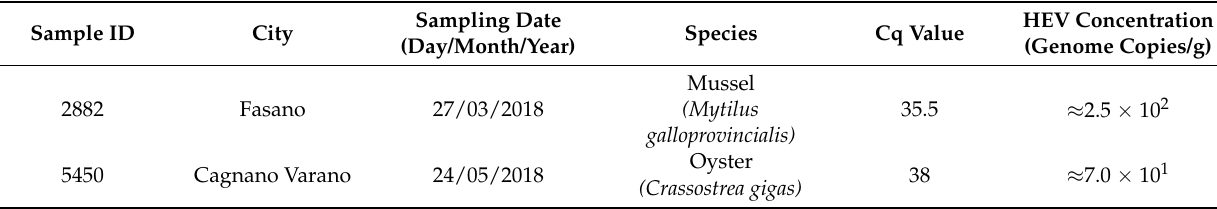
Table 2. Sampling date, city, Cq values, and HEV concentrations (genome copies/g) of the samples positive for HEV RNA. Sample